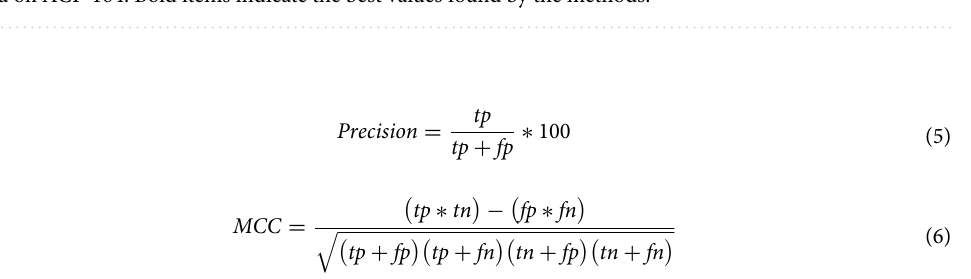
Table 5. Results achieved using independent test for ACP-500/164 dataset. Model trained on ACP-500 and tested on ACP-164. Bold items indicate the best values found by the